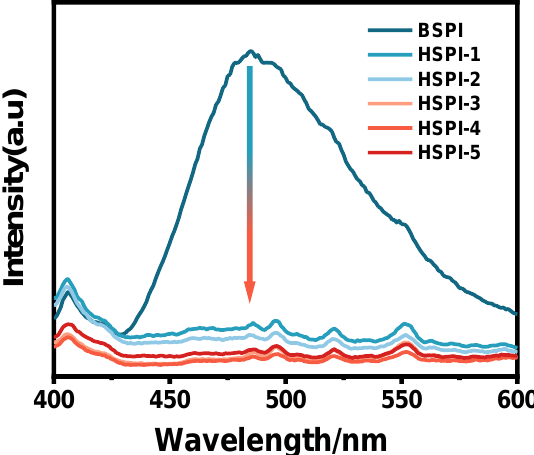
Figure 9. Comparison of photoluminescence spectra of the BSPI and HSPI samples.